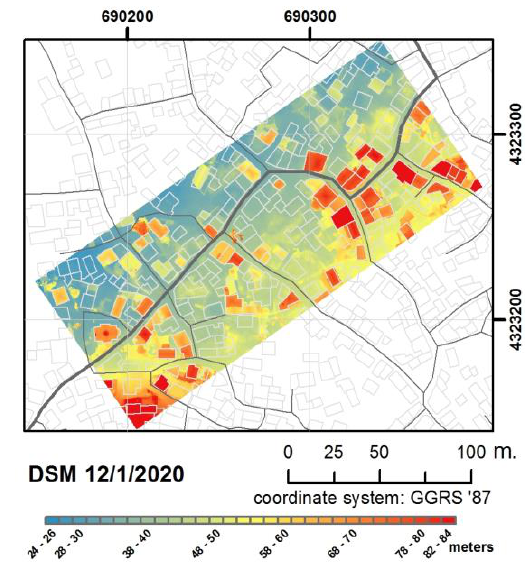
Figure 3. DSM (5.65 cm/pix) derived from the first flight of 100